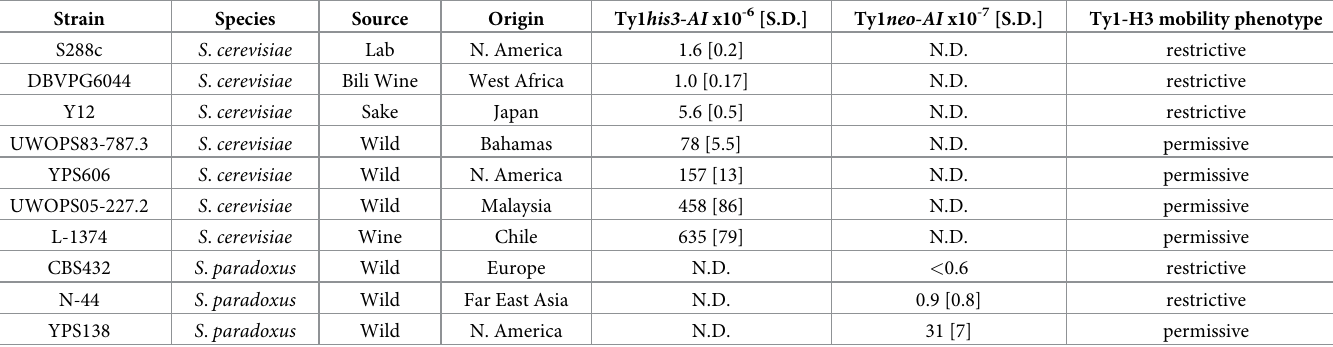
Table 1. Canonical Ty1-H3 mobility in a diverse panel of S . cerevisiae and S . paradoxus